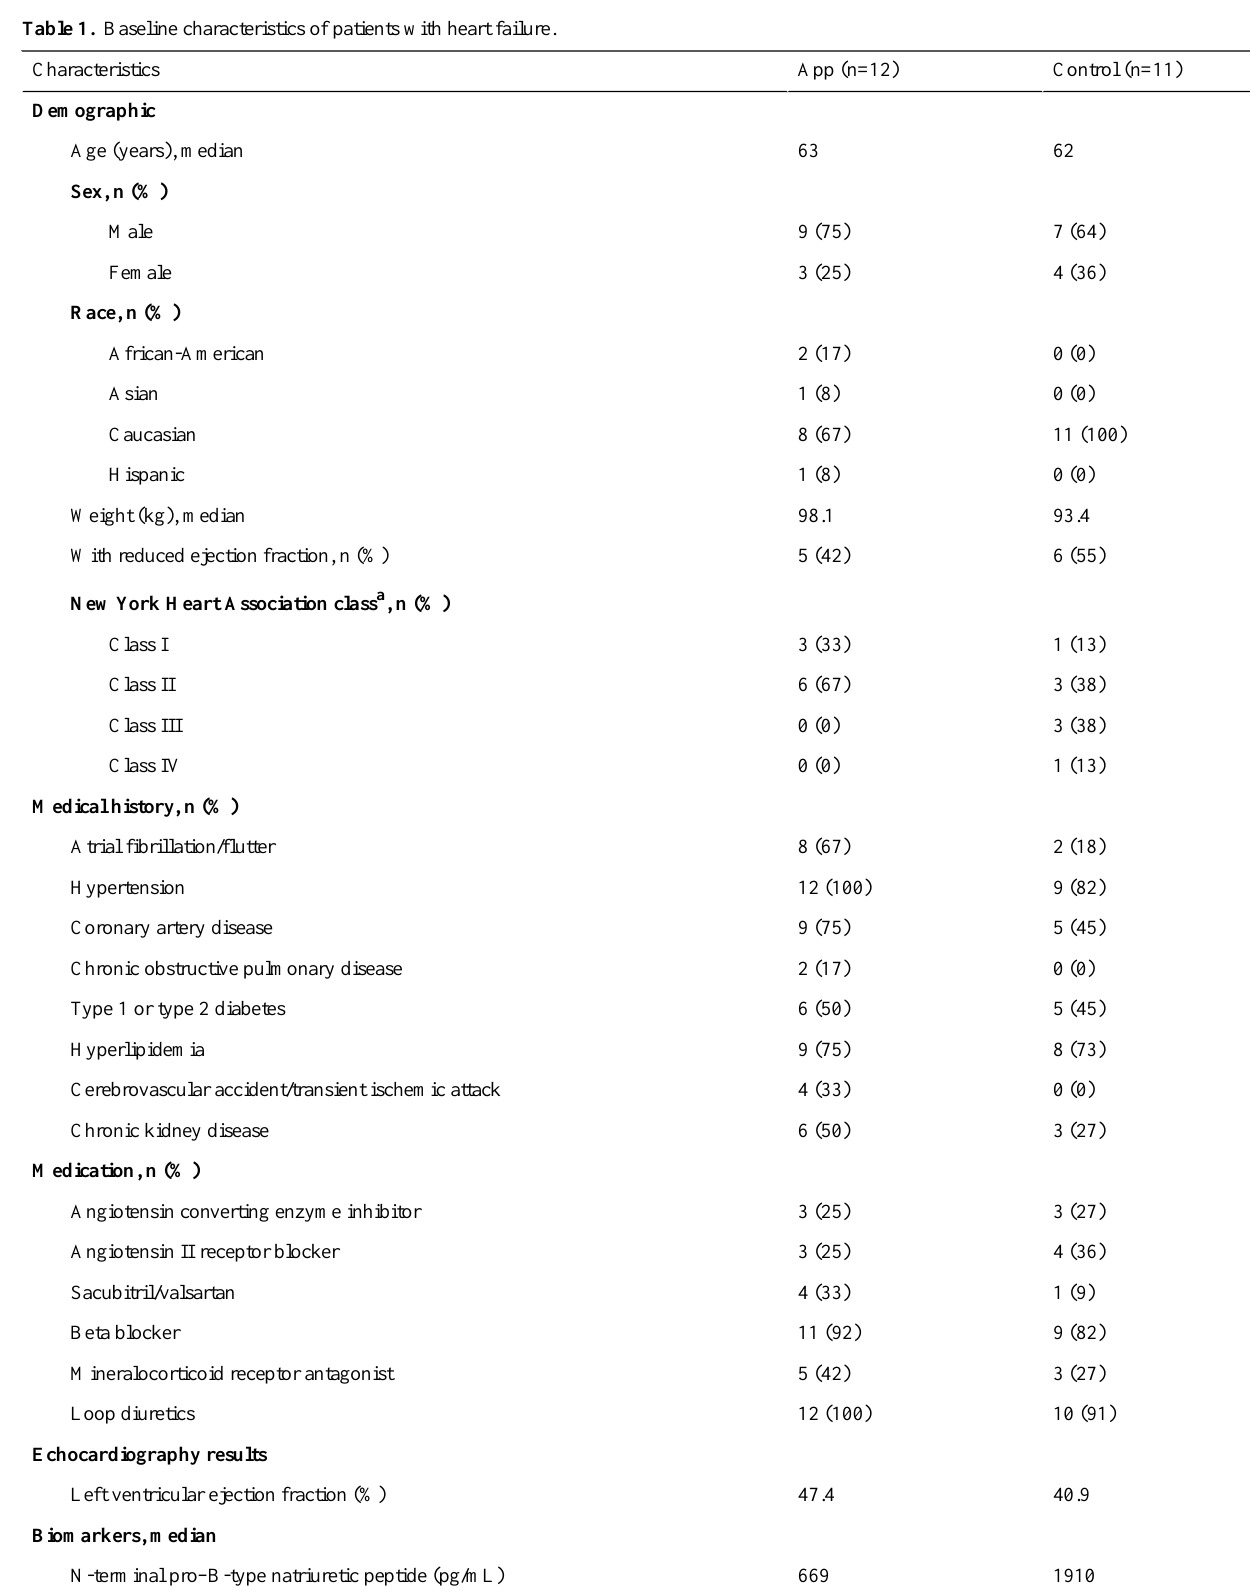
Table 1. Baseline characteristics of patients with heart